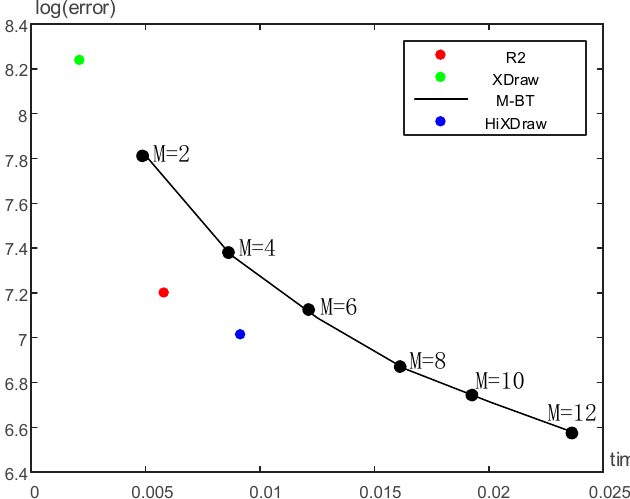
Figure 8. Comparison of different algorithms taking both accuracy and efficiency into consideration. Assume the time of R3 is one. The x-axis represents the relative time used by each algorithm. The y-axis represents the number of error determinations in logarithm. The performance of M-BT (black) varies with backtrack order from two to twelve. HiXDraw (blue) is more accurate but slower than XDraw (green) and R2 (red). Although M-BT can achieve higher accuracy with a high backtrack order, HiXDraw expends shorter time achieving the same